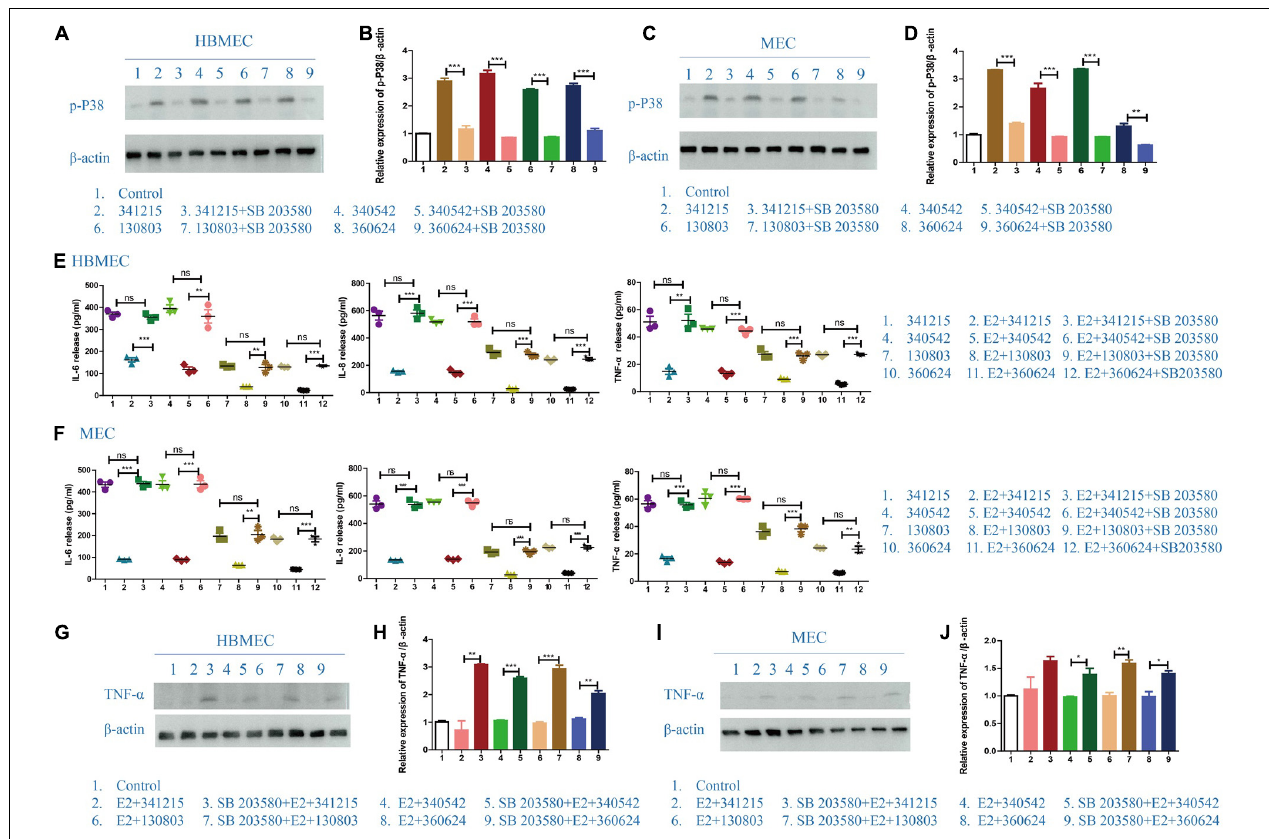
FIGURE 4 | The effect of p38-MAPK signaling pathway on the role of E2 in Neisseria meningitidis -infected cells. (A–D) P38-MAPK signal pathway inhibitor, SB203580, was used in N. meningitidis -infected HBMECs (A) and MECs (C) . Proteins were extracted for western blotting analysis. The activation of p-p38 was detected and β -actin was used as the internal control. The changes in protein levels in HBMECs (B) and MECs (D) were analyzed using Image-J software and the gray values were analyzed statistically using GraphPad Prism software. (E,F) HBMECs (E) and MECs (F) were treated with the following three treatments: N. meningitidis infection, E2- N. meningitidis co-stimulation, SB203580-E2- N. meningitidis co-stimulation, and the cell supernatant was collected. ELISA assays were used to detect the levels of IL-6, IL-8, and TNF- α in the supernatant. (G–J) HBMECs (G) and MECs (I) were divided into three experimental groups as